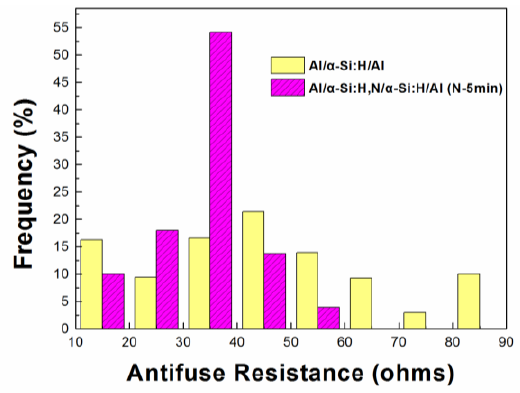
Figure 6. Resistance distribution for the programmed Al/ α -Si:H/Al and Al/ α -Si:H,N/ α -Si:H/Al (N-5min) antifuses.